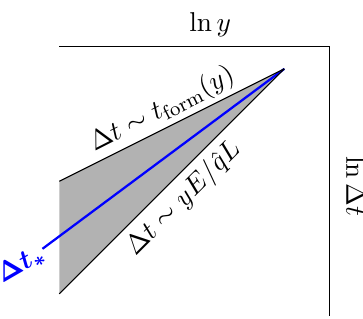
Figure 14 . A choice of intermediate scale ∆ t ∗ ( y ) splitting the (shaded) double log region of figure 1. Remember that we (parametrically) define L = t form ( x ) in our